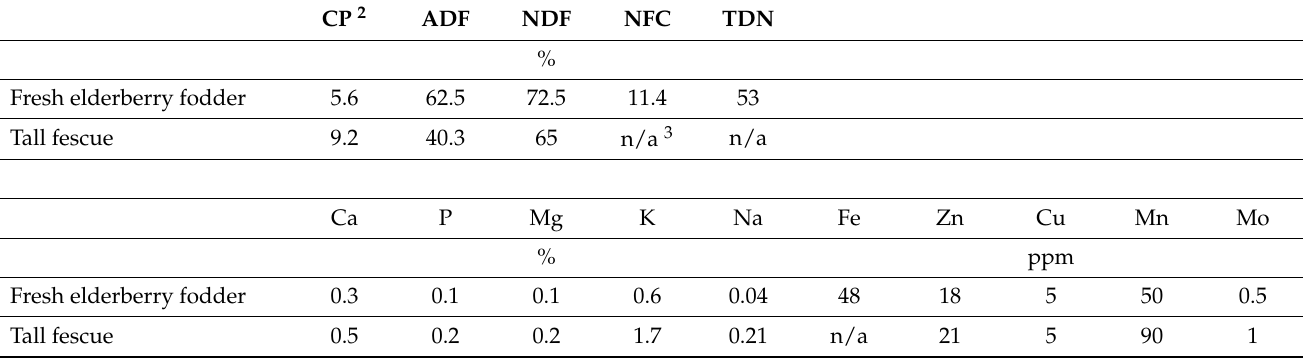
Table 1. Nutritive value for pre-ensiled elderberry fodder and NASEM 1 tall fescue values for